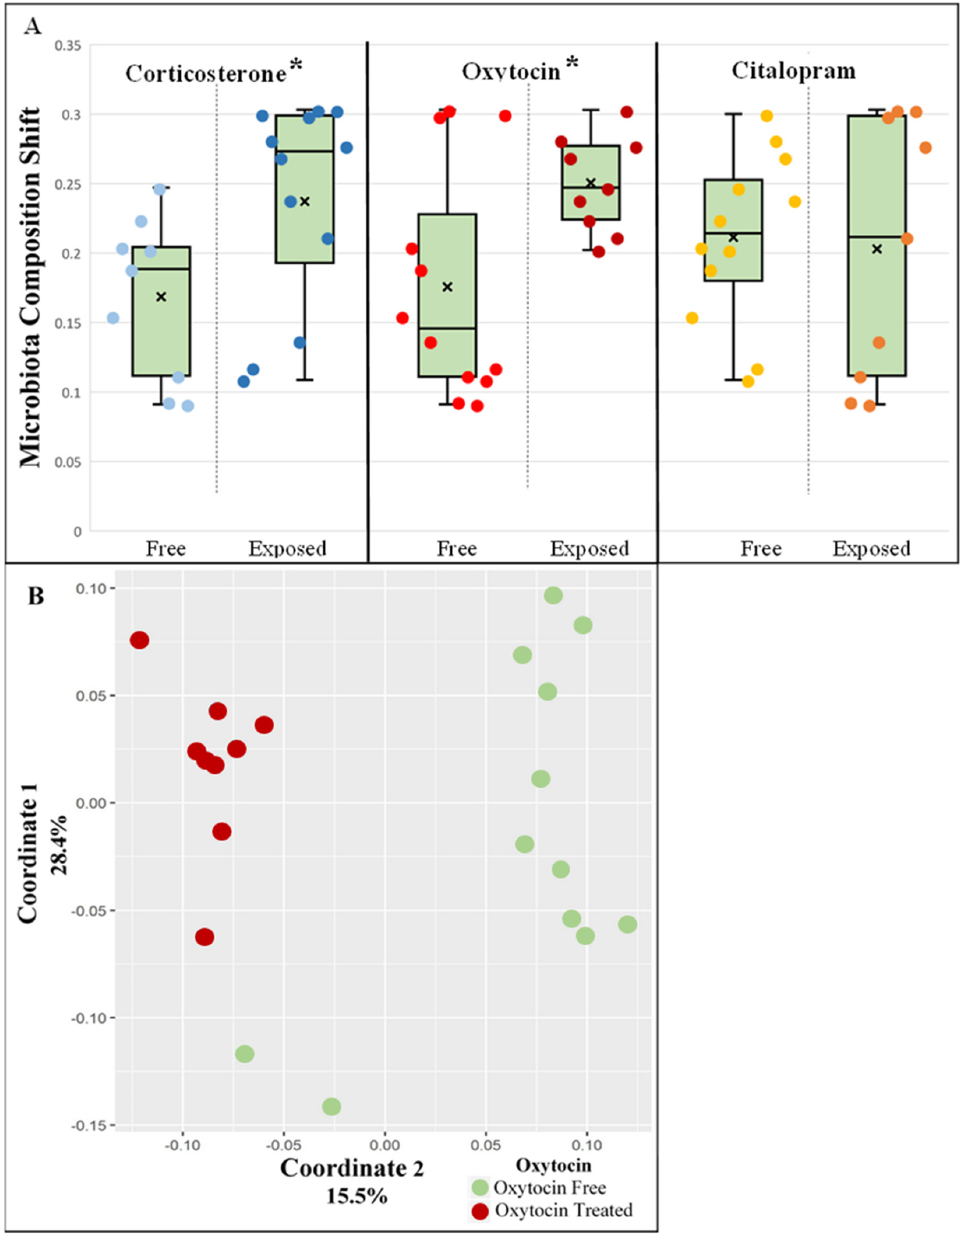
Figure 2. Treatment effect on microbiota: ( A ) the microbiota composition shift (unweighted UniFrac distances between phase I (pre-treatment) and phase II (post-treatment) microbiota samples) n ; each point represents a single cage. * Significant p -value (<0.05); ( B ) PCoA of the unweighted UniFrac matrix of all—post-treatment samples. ANOSIM, p = 0.001, R = 0.6.